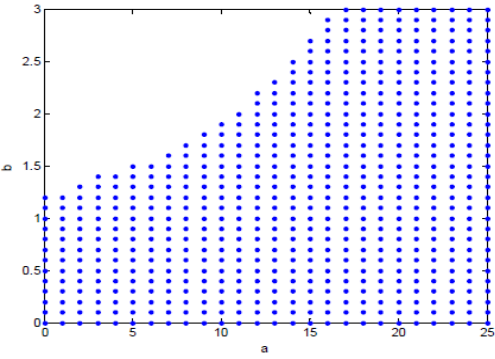
Figure 5. Stability regions for m = 10 and δ =